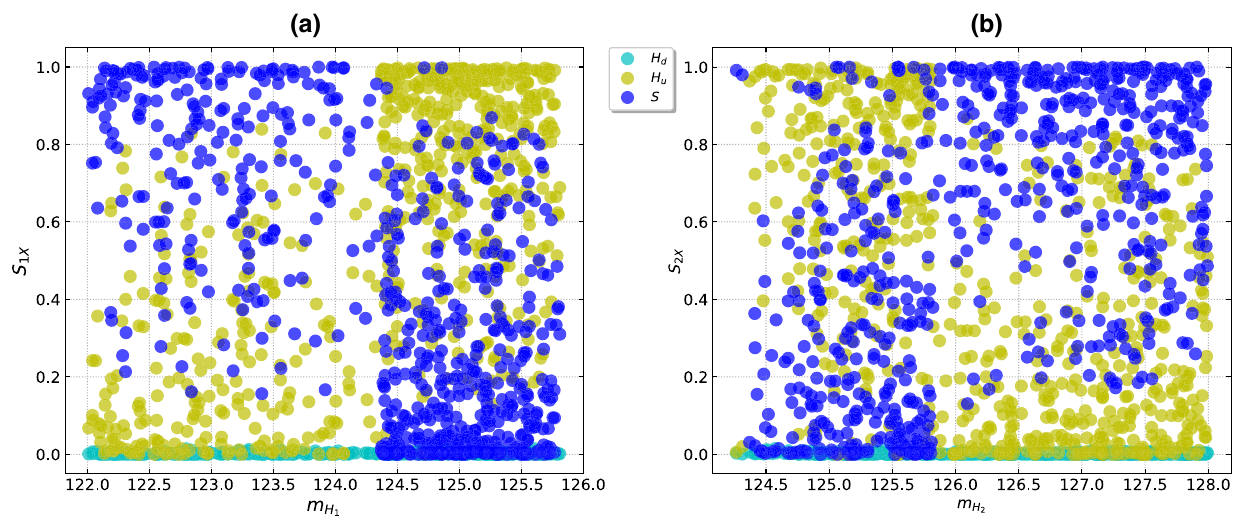
Fig. 3 The double ratios D 1 , D 2 , D 3 defined in Eq.(10), as functions of the mass difference m H to the total χ 2 calculated by HiggsSignals